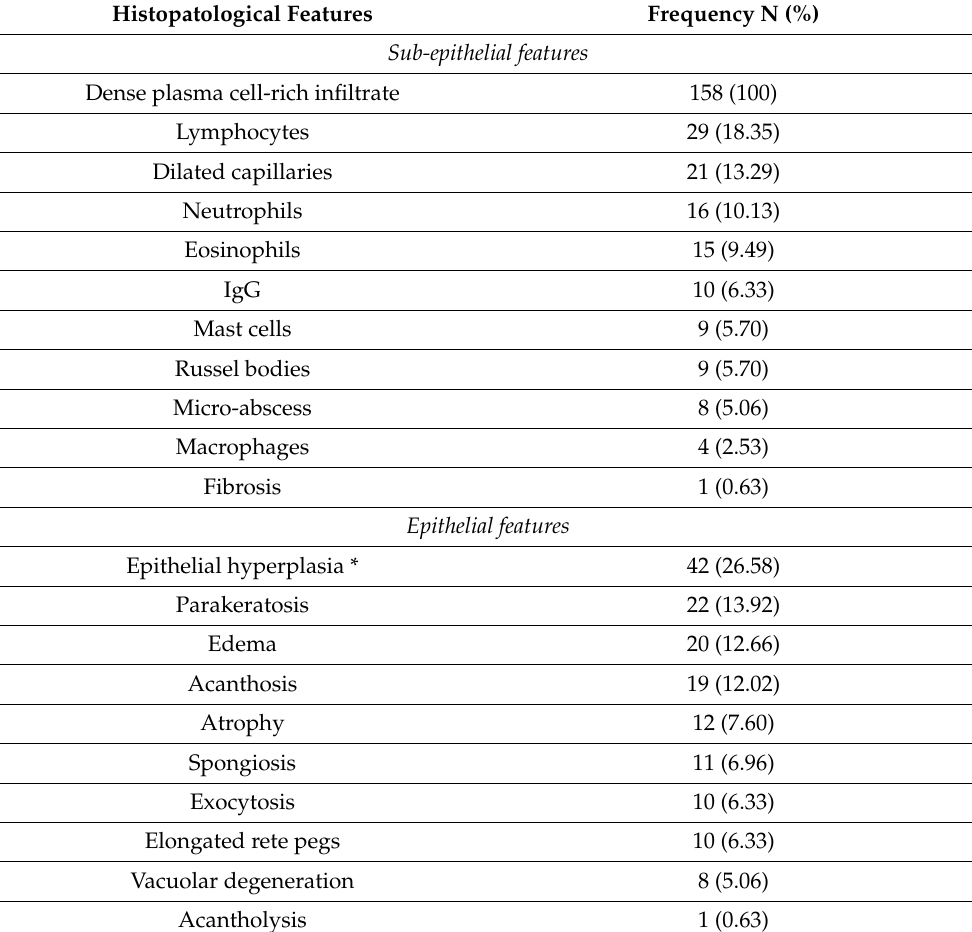
Table 4. Summary of histopathological findings.